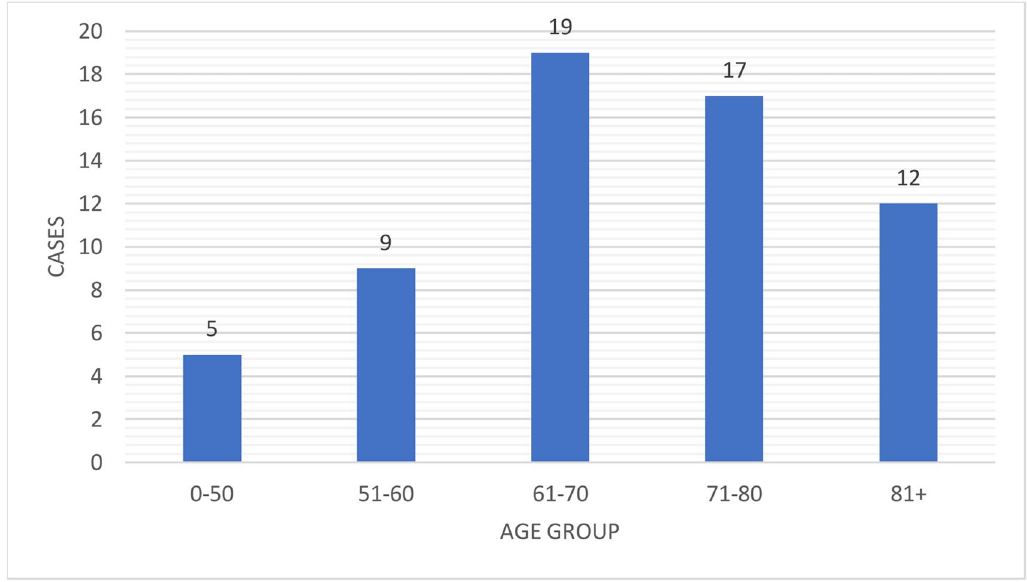
Figure 3. Age distribution of oral squamous cell carcinoma patients at time of